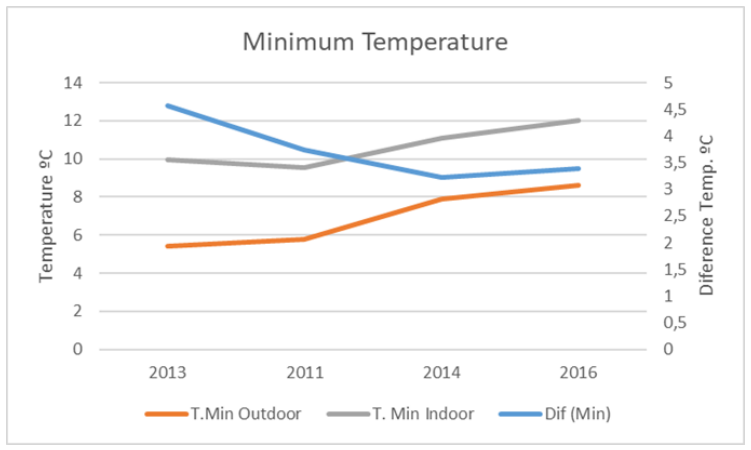
Figure 17. Minimum indoor and outdoor temperature and their difference in winter.